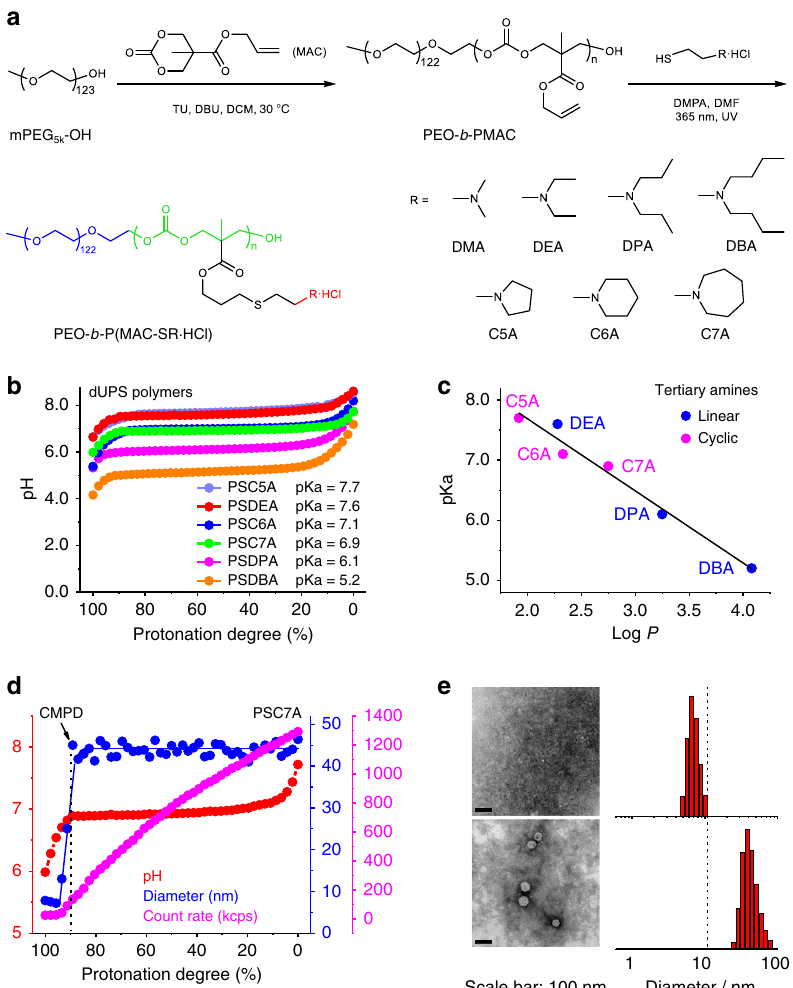
Fig. 1 Micellization-induced ultra-pH sensitivity of degradable ultra-pH sensitive (dUPS) polymers. a Synthesis of PEO- b -P(MAC-SR·HCl) (abbreviated as PSR) by ring-opening polymerization and thiol-ene reactions. The fi nal copolymers consist of a hydrophilic PEO segment (blue), a degradable polycarbonate backbone (green), and ionizable tertiary amines lending pH sensitivity (red). b dUPS polymers display ultra-pH sensitivity and strong buffer capacity at their relative pK a . PSDMA titration is presented separately in Supplementary Fig. 10. c pK a values are inversely correlated with the log P of the repeating unit of the P(MAC-SR) segment (neutral/deprotonated state). d Number-weighted hydrodynamic diameters and light scattering count rates as a function of protonation degree during the PSC7A titration. CMPD: critical micellization protonation degree. e TEM images and corresponding number- weighted hydrodynamic diameter distributions by dynamic light scattering (DLS) analysis of PSC7A in 150 mM NaCl solution at 95% and 85% protonation degrees, above and below CMPD. Scale bar: 100 nm. TEM measurements of PSC7A polymer solutions at 85% and 95% protonation degrees were repeated three times independently with similar results, and one representative image from each group was